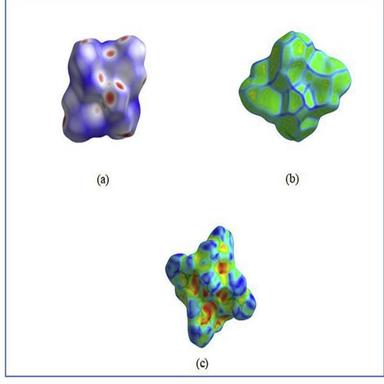
Hirshfeld surfaces of tetrakis(thiourea)cobalt chloride (TTCoC) single crystal. (a): Hirshfeld surface mapped over dnorm of TTCoC crystal; (b): curvedness of TTCoC; (c): Hirshfeld surface of TTCoC mapped over the shape index.